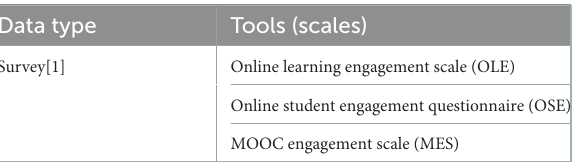
TABLE 7 Self-report measures of learning engagement in massive open online